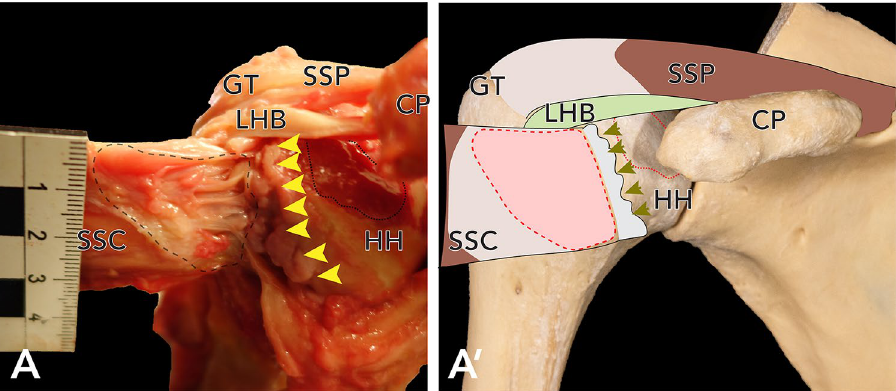
Figure 2. ( A ) Large partial SSC-lesion in a right shoulder, view from anterior. In this shoulder, also a large cartilage-defect was identified. Dashed line delineates the size of the SSC-lesion, dotted line delineates the cartilage-defect. Arrowheads demarcate the degenerated joint capsule. ( A ′ ) Approximation of the photographs as an overlay on humerus and scapula. HH humeral head, CP coracoid process, SSC remainder of the supscapularis muscle.